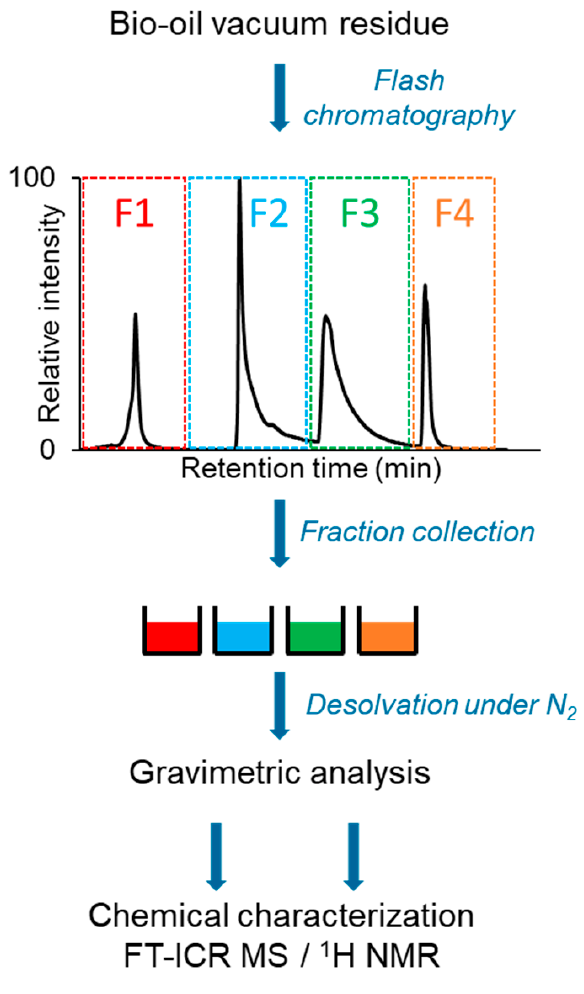
Figure 4. Scheme of the experimental workflow from sample fractionation to gravimetric analysis and molecular characterization. The diagram was reprinted with permission from Ref. [95]. 2022 , Elsevier .